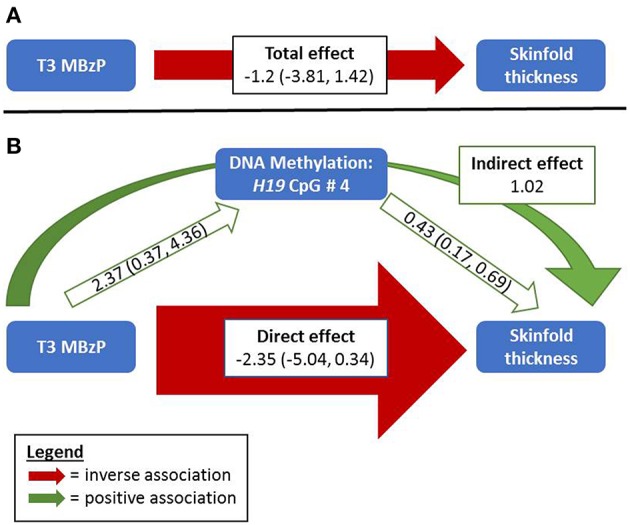
Relationships between MBzP, DNA Methylation, and Skinfold Thickness among Girls. (A) Without considering DNA methylation, third trimester MBzP exposure is negatively associated with repeat measures of skinfold thickness among girls measured at two time points in late childhood/adolescence. (B) Including DNA methylation of H19 as a potential mediator in the model reveals a stronger negative direct effect of MBzP on skinfold thickness that was masked by the positive relationships between H19 DNA methylation with both MBzP and adiposity. The Sobel test for non-zero mediation in this example nears statistical significance (p = 0.06). While this example shows effect estimates for H19 CpG 4 and skinfold thickness, similar relationships are observed with H19 CpG sites 1 and 4 with three adiposity measures among girls (Supplemental Table 1). Width of the arrows indicate relative magnitude of association, although they are not to scale. The total and direct effects reported here are estimated parameters from models of the outcome without and with the mediator, respectively. The indirect effect is from a non-parametric calculation (the product of the effects of the exposure on the mediator and of the mediator on the outcome).